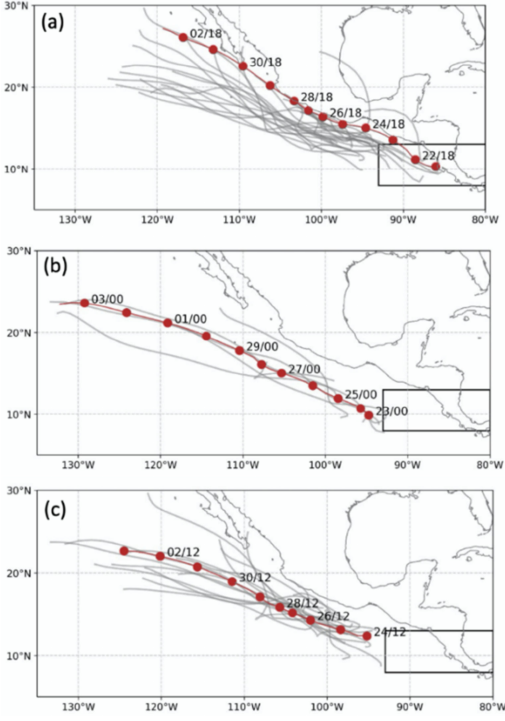
Figure 5. ECEPS 12 UTC 18 June 2021 forecasts of ensemble member tracks (gray lines) and the Weighted Mean Vector Motion (WMVM) tracks (red lines with dots labeled DD/MM) at 48 h intervals) with old procedure ( a ) Storm 4 and ( b ) Storm 5, and with new procedure ( c ) Storm 17 in which all ensemble member tracks within the small box in the lower right have been excluded (see